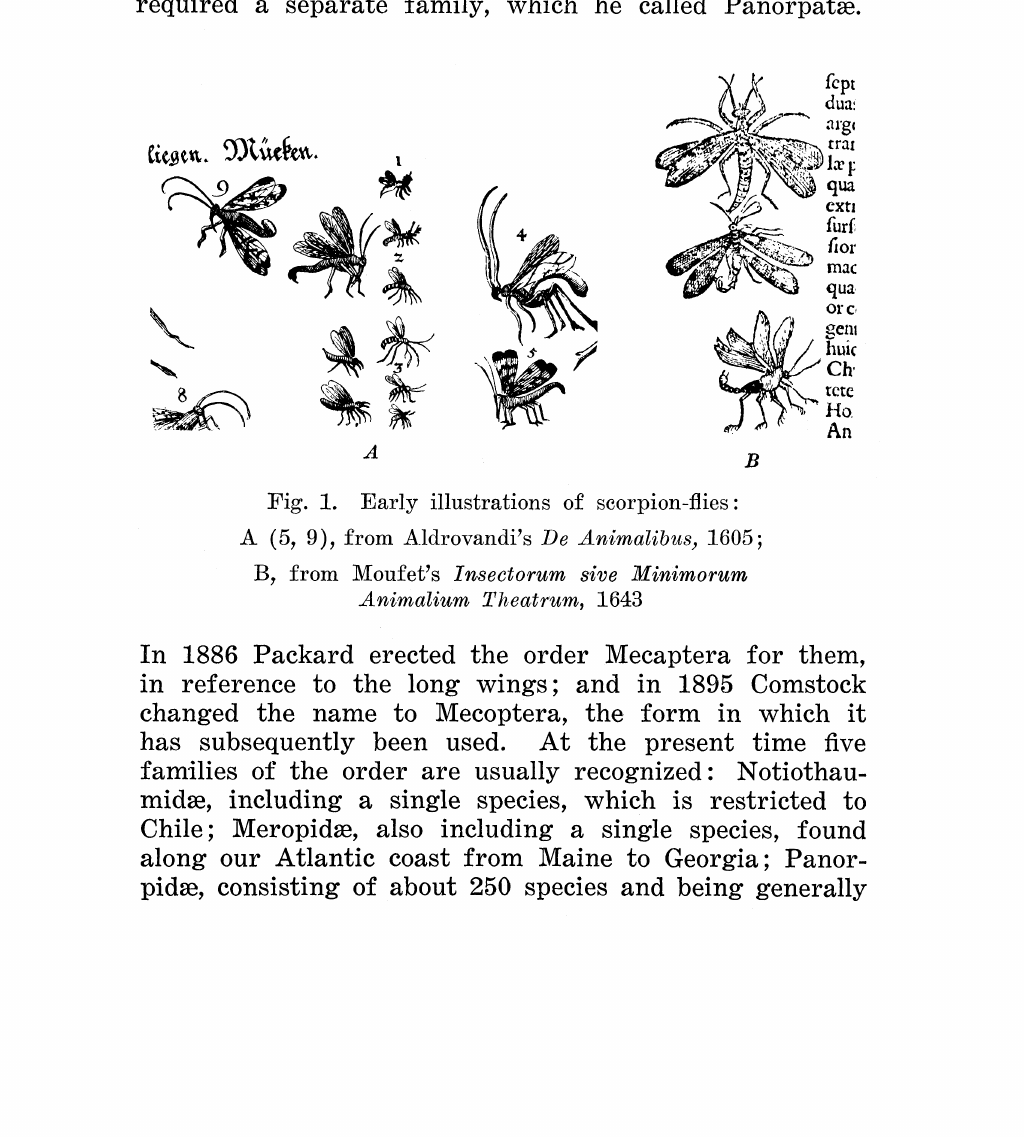
Fig. 1. Early illustrations of scorpion-flies: A (5, 9), from Aldrovandi’s De Animalibus, 1605; B, from 5Ioufet’s Insectorum sire Minimorum Animalium Thea.trum,